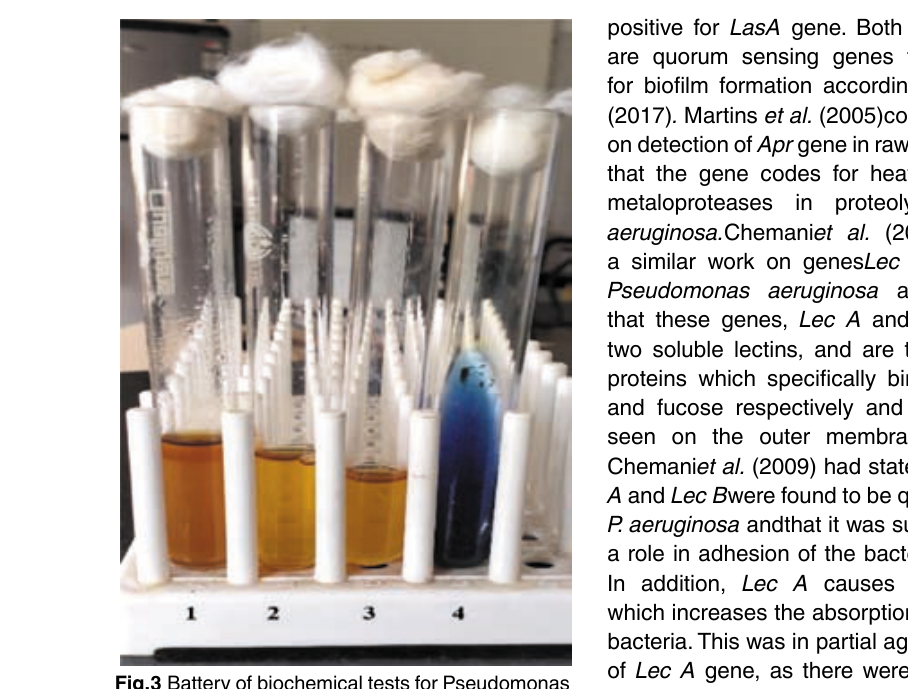
Fig.3 Battery of biochemical tests for